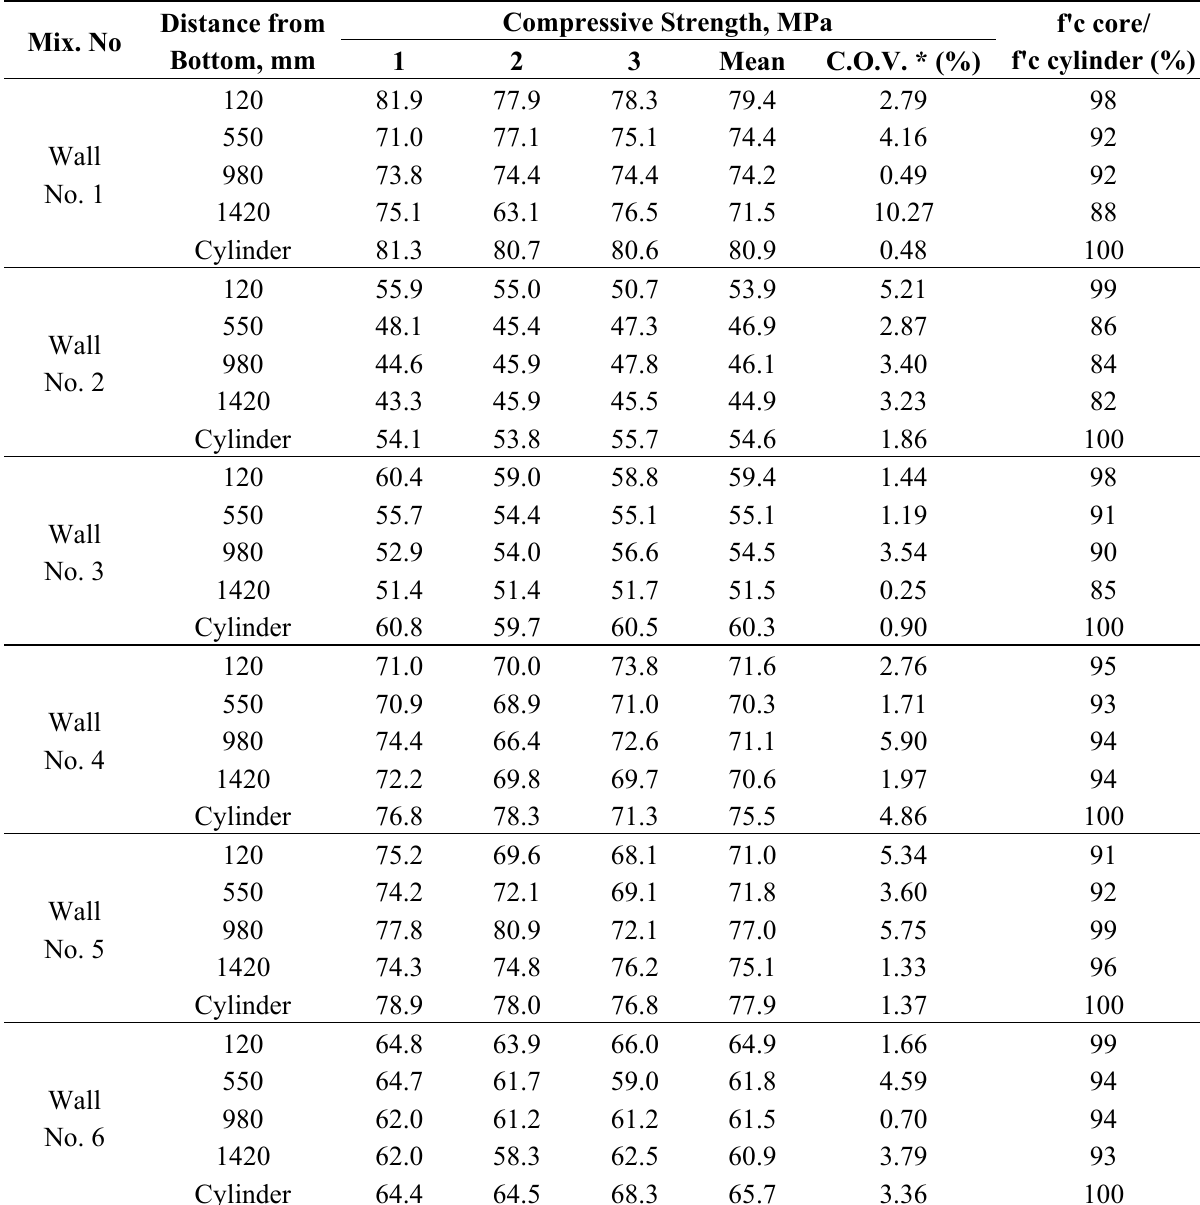
Table 3. In-place compressive strength of wall elements cast with SCC and HPC with different stability